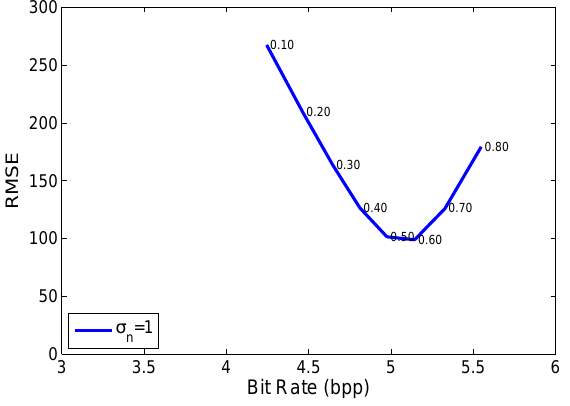
Figure 12. RMSE versus BR by varying K min for the Yellowstone scene 0 in the BSQ format.